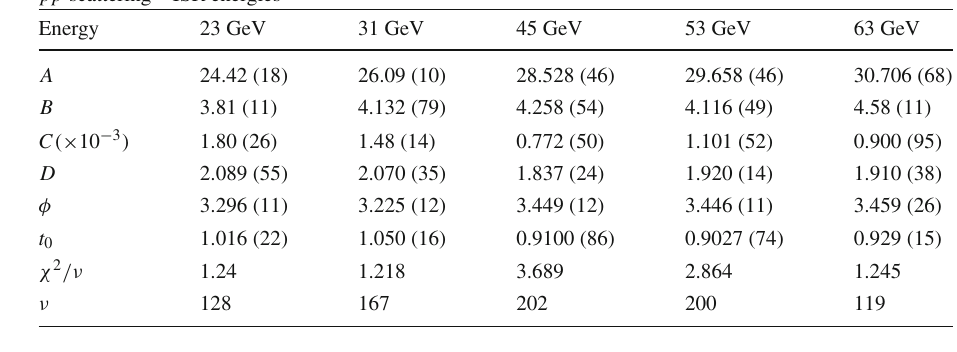
Table 2 Results for the fits of the differential cross section data considering pp scattering at LHC energies. The reduced χ 2 and degrees of freedom, ν , for each fit are also presented